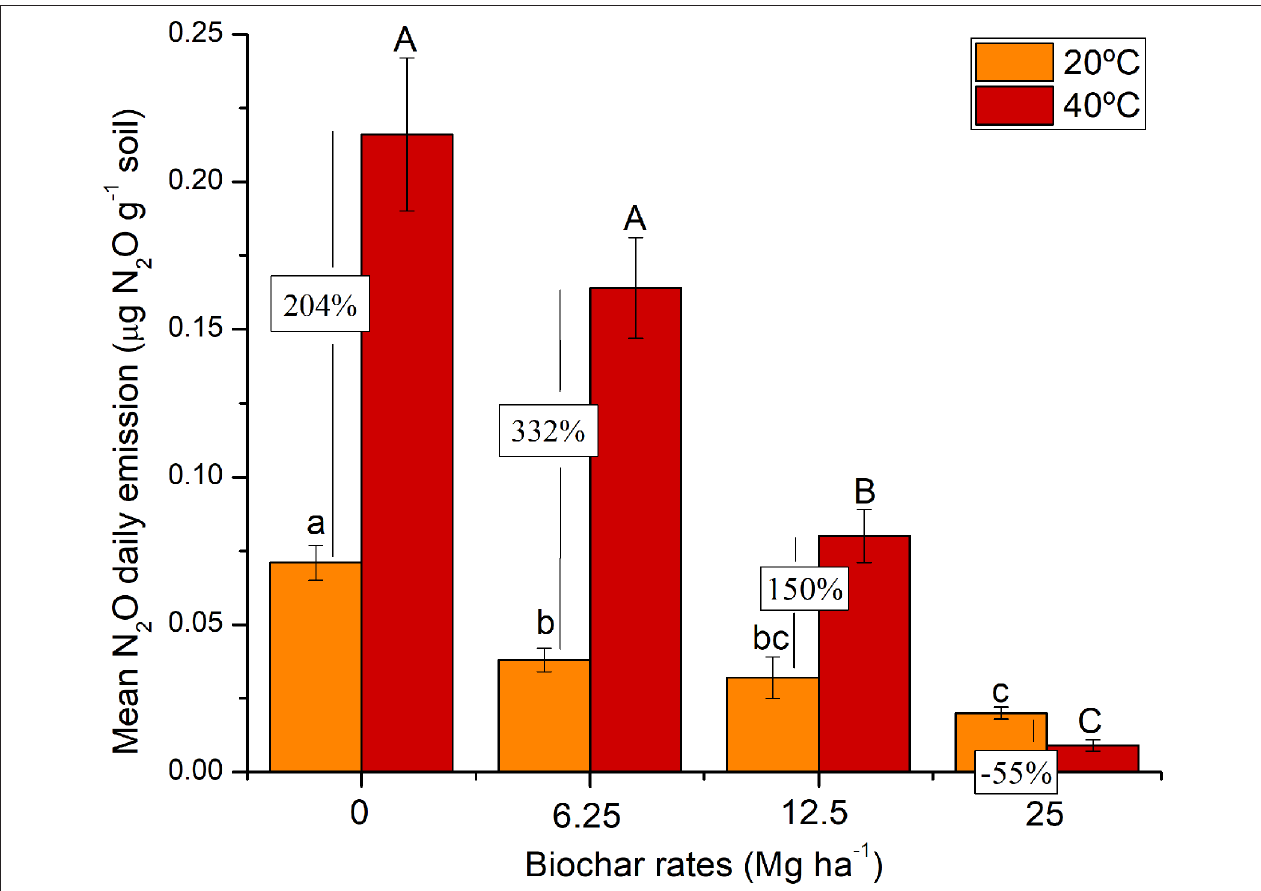
FIGURE 1 | Mean daily N 2 O emissions ( ± SE, n = 3) observed for an 88-day laboratory incubation of tropical soil with different Miscanthus biochar application rates (0, 6.25, 12.5, and 25Mg ha − 1 ). Yellow and red colors show the results for 20 and 40 ◦ C incubation temperatures. Uppercase letters indicate significant differences between biochar rates at 40 ◦ C. Lowercase letters indicate significant differences between biochar rates at 20 ◦ C. The percentage (%) indicates an increase or decrease in N 2 O emissions at 40 ◦ C compared to 20 ◦ C (ANOVA, paired-samples t -test, p <